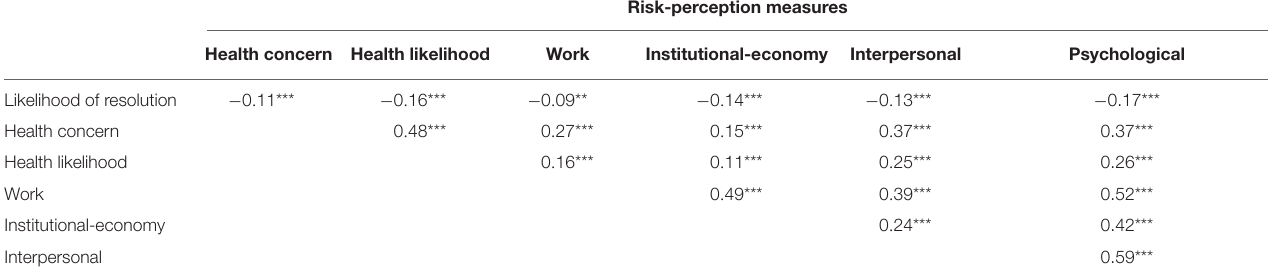
TABLE 4 | Pearson’s Correlations among risk-perception measures and risk-related